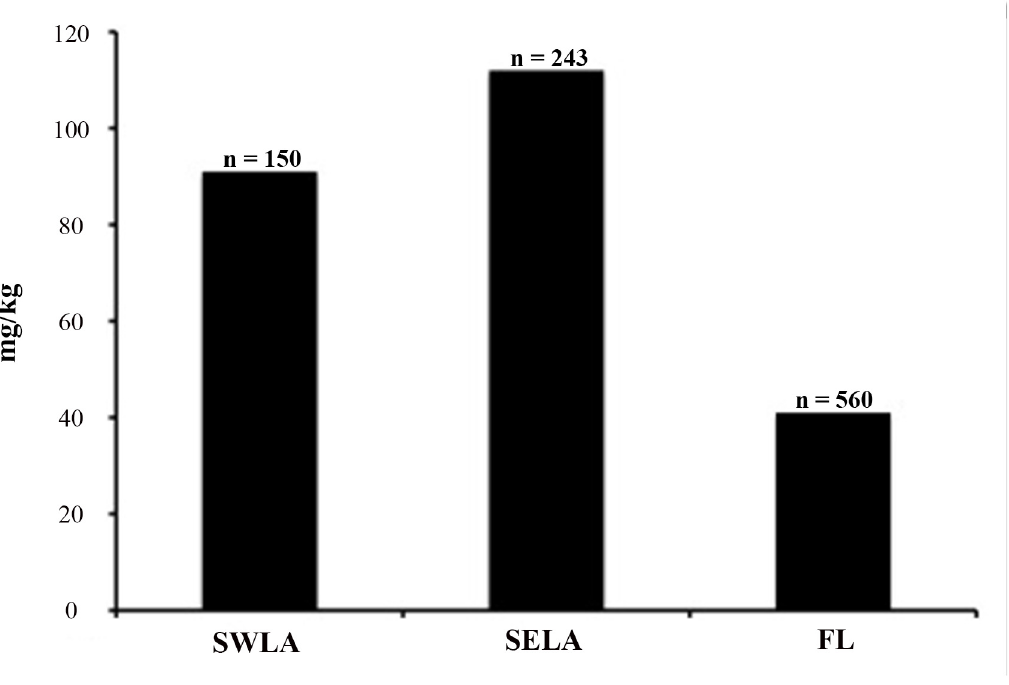
Fig 2. Comparative data of As concentrations among pentastomids from SWLA, SELA, and FL. Quantity of pentastomids analyzed from each region is shown (n =).